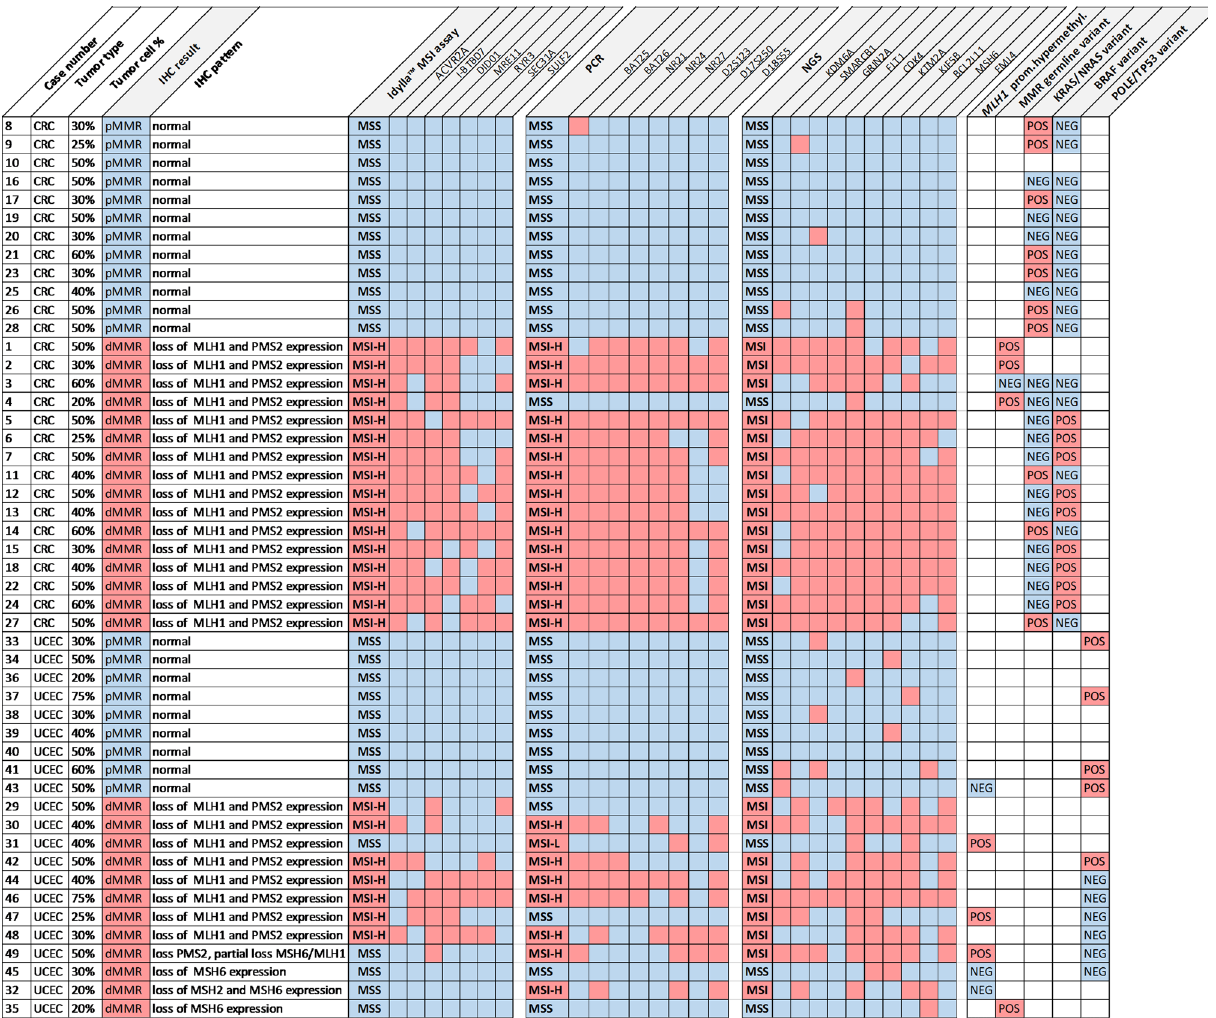
Figure 2. MSS/MSI calling at locus level and integrative panel-based result for Idylla MSI assay, PCR and NGS versus immunohistochemistry. Samples are grouped according to colorectal (CRC) or uterine corpus endometrial carcinoma (UCEC) tumor type and MLH1/PMS2/MSH2/MSH6 immunohistochemical expression pattern with from top to bottom: pMMR CRC (n = 12), dMMR CRC (n = 16), pMMR UCEC (n = 9) and dMMR UCEC (n = 12) samples with the indicated tumor cell percentage, IHC pattern and case number. From left to right the results are shown of MSI calling in the 7, 8 and 10 loci of the Idylla MSI test, PCR and NGS- respectively. For each molecular technique the overall integrative binary scoring as microsatellite stable (MSS, blue) or microsatellite unstable (MSI, MSI-L: MSI-low; MSI-H: MSI-high, red) is listed first, followed by the scoring of the individual loci. Right columns indicate the presence (red, POS: positive) or absence (blue, NEG: negative) of pathogenic variants in NRAS/KRAS and BRAF in CRC and MLH1 promoter hypermethylation and (likely) pathogenic germline variants in MMR genes (MLH1, MSH2, MSH6, PMS2) in UCEC. Blank fields indicates parameter not assessed. Details on identified variants in supplementary Table ranging from 82 to 86%. All three molecular assays showed better diagnostic performance in CRC than in UCEC, but within each tumor type their diagnostic power as measured by AUC was equivalent. In CRC, sensitivity was 100% (95% CI 79%-100%) for Idylla MSI assay. PCR and NGS were both falsely nega- tive in the same CRC sample (case 4 in Fig. 2, detailed in Fig. 5) with a low percentage of tumor cells (20%) which is sufficient for the Idylla MSI assay but below the optimal tumor cell percentage of at least 30% tumor cells for confident calling by PCR and NGS. Assuming a prevalence of 15% microsatellite unstable tumors in CRC, these high sensitivities translate into excellent negative predictive values (NPV) of 99–100%. In UCEC, specificity of molecular assays was also 100%. Sensitivity, however, was clearly lower ranging from 58% (95% CI 28–85%) for Idylla MSI assay, 67% (95% CI 35–90%) for PCR to 75% (95% CI 43–95%) for NGS (Table 1). In a typical clinical cohort of endometrial cancers with 40% prevalence of MSI 38 , this translates into NPV of 78% for Idylla MSI assay, 82% for PCR and 86% for NGS. When diagnostic performance was expressed versus the consensus result of all three molecular tests (Supplementary Table S7), NGS achieved the highest sensitivity (90%, 95% CI 55–100%) at 100% specificity in endometrial cancers, though not significantly higher than the sensitivity of PCR (80%, 95% CI 44–98%) or Idylla MSI assay (70%, 95% CI 35–93%).